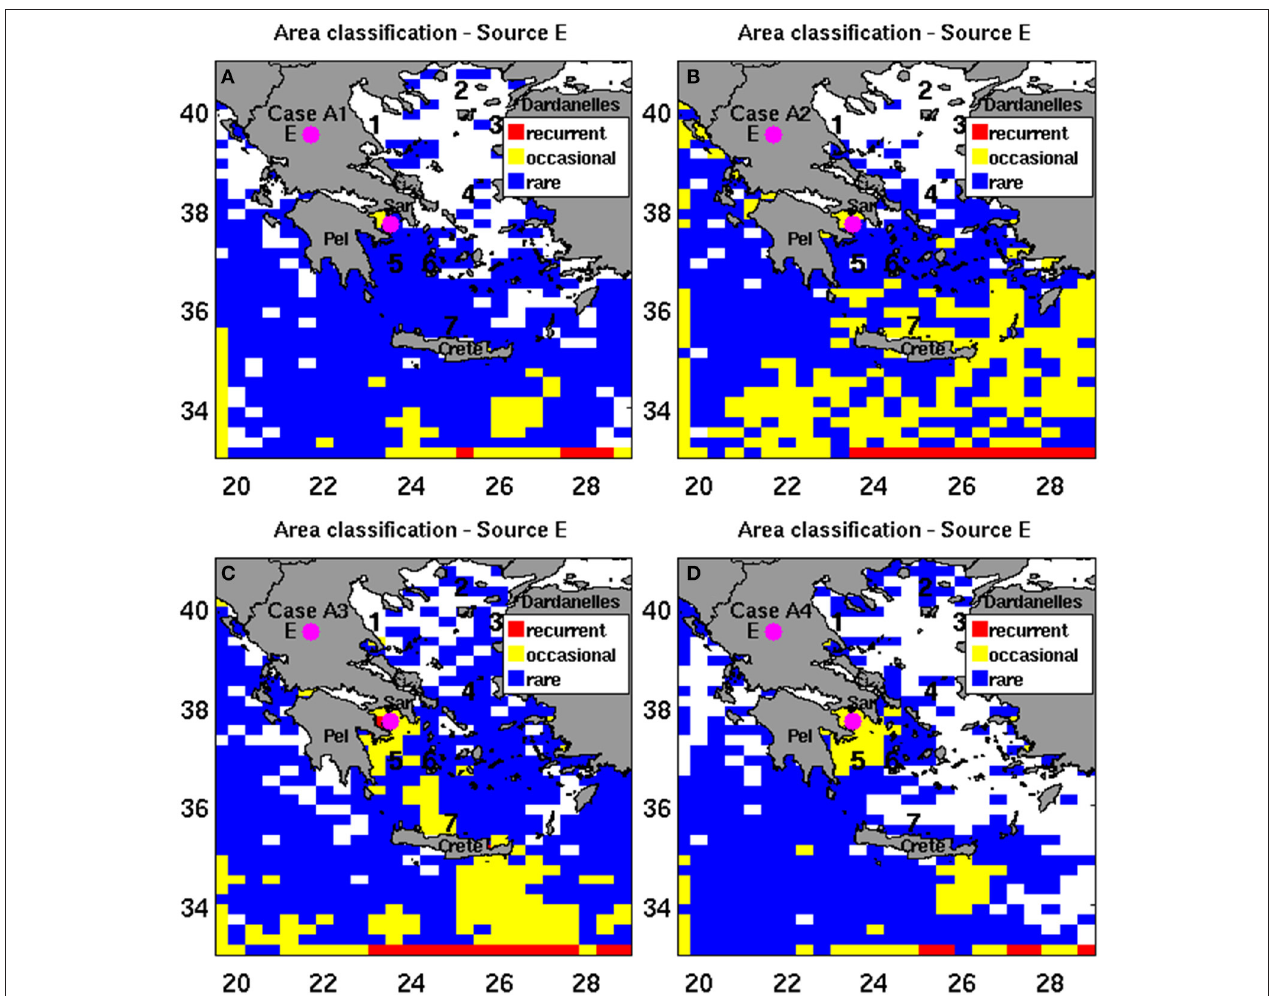
FIGURE 9 | Area classification maps of floating litter particles originated from Source region E (Saronikos Gulf) in Cases (A) A1, (B) A2, (C) A3, and (D) A4. Magenta dot point indicates the source region E.